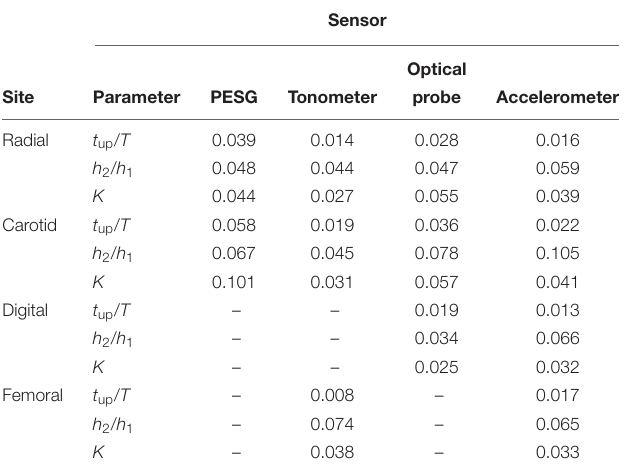
TABLE 4 | Coefficients of variation for the derived pulse wave parameters, acquired by the four kinds of pulse sensors from the four measuring sites (missing values relate to probe/site combinations for which measurements were impracticable).